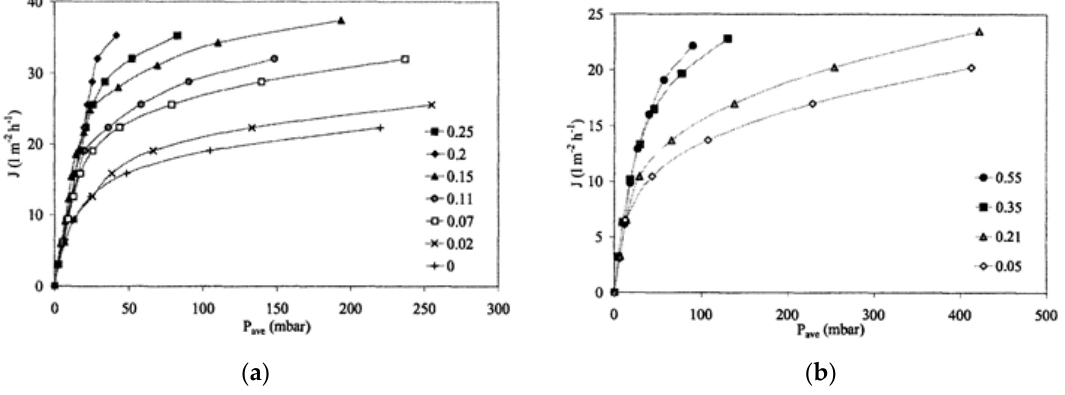
Figure 4. Flux J vs. average pressure P ave at ( a ) various air flow velocity in sub-MBR configuration ( b ) values cross-flow velocity (m/s) in ss-MBR configuration [111].